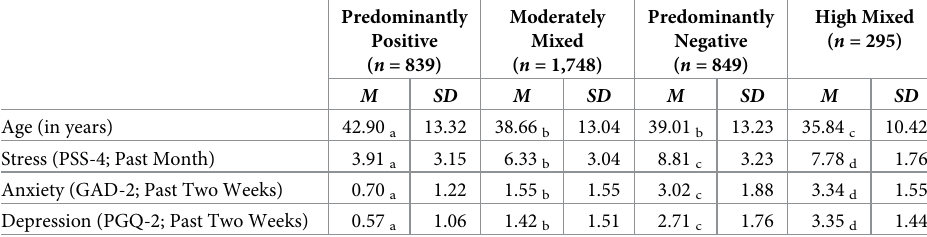
Table 5. Differences in age and psychological distress across latent